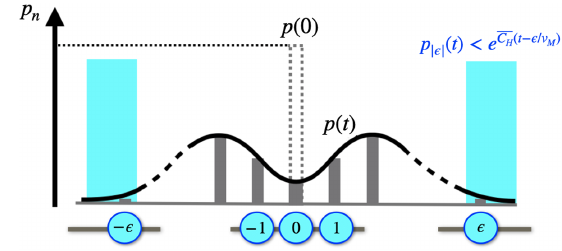
FIG. 13. Schematic illustration of the exponential suppression of the tail (shaded in cyan) of the probability distribution p ( t ) given in Eq. (134), where p n ( 0 ) = δ 0 n is FIG. 12. Time dependence of the speed of the sum of the posi- ˙ˆ tions of the particles, |(cid:3) X (cid:4)| (black), from the initial state | (cid:13) 1 (cid:4) [the same situation discussed in Fig. 9(a)]. In contrast with the bounds B p in Eq. (45) (red) and B H in Eq. (48) (green), the quan- ˙ˆ tity D (purple) in Eq. (130) with c = 2 cannot bound |(cid:3) X (cid:4)| . This indicates that the trade-off relation between time and energy fluc- tuation does not hold in our formalism. We note that the bound B UR in inequality (2) (gray), which is based on the standard trade-off relation between time and energy fluctuation, provides ˙ˆ a rather loose upper bound for |(cid:3) X (cid:4)| .